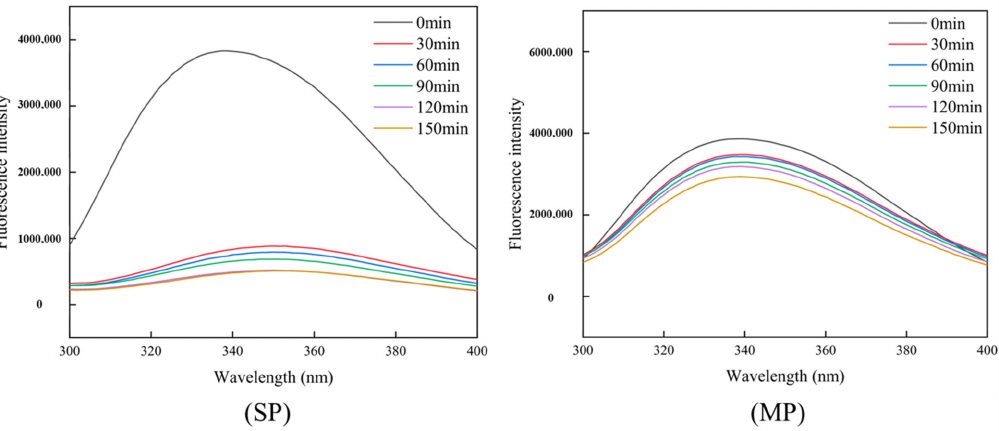
Figure 3. E ff ects of stewing time on endogenous fl uorescence intensity of Sichuan − style braised beef Figure 3. Effects of stewing time on endogenous fluorescence intensity of Sichuan-style braised beef protein. Foods 2023 , 12 , x FOR PEER REVIEW protein.